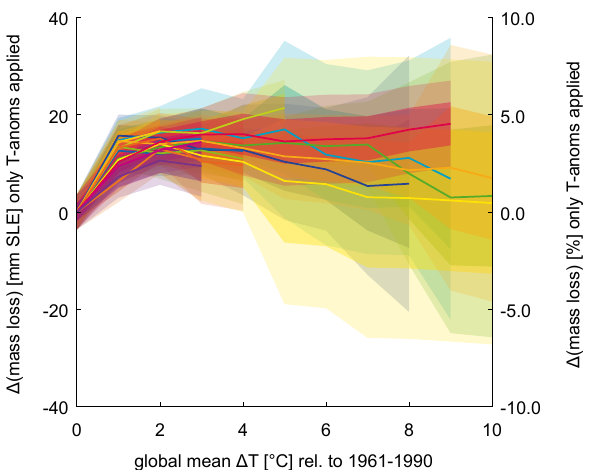
Fig. 3. Additional equilibrium mass loss of glaciers when only tem- perature anomalies are applied, and precipitation anomalies are ig- nored. Dark (light) shading indicates one (two) standard errors. Col- ors as in Fig. 2.